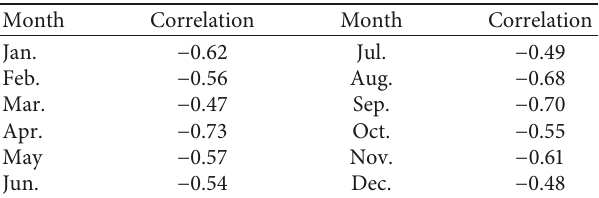
Table 2: The average correlations between the TVDI and SPEI-3 values at the stations obtained in each month in